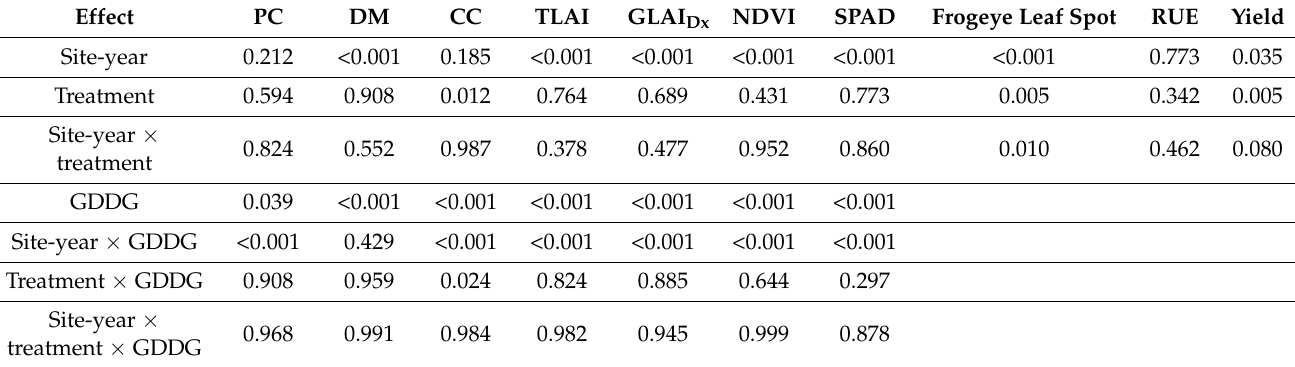
Table 2. Analysis of variance for different variables z to test the effects of site-year, treatment, growing degree day group (GDDG), and their combinations in field experiments conducted in Kanawha and Lewis County Iowa in 2018 and